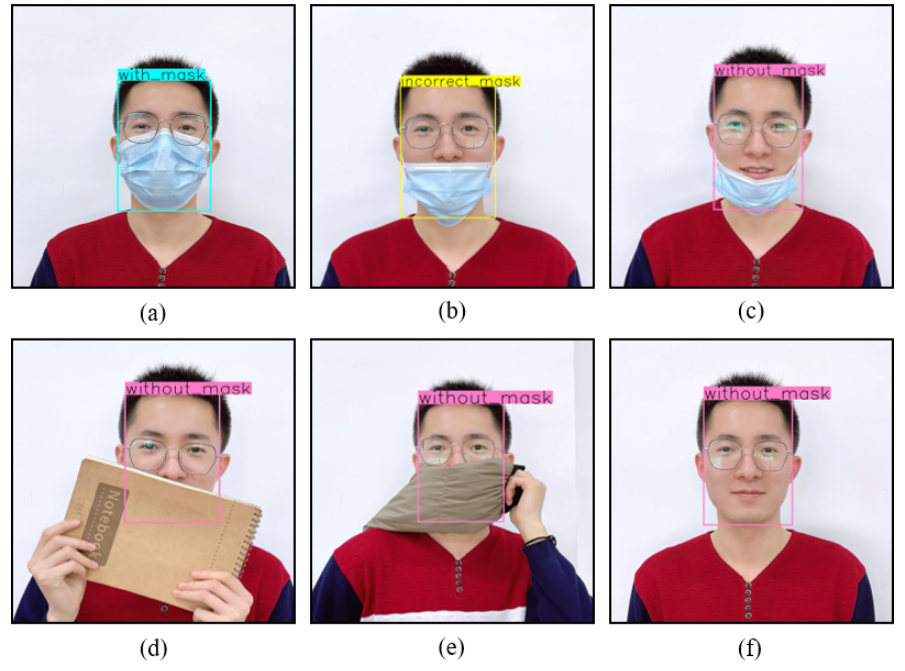
Figure 4. ( a ) Faces with both nose and mouth covered are labeled as “with_mask”. ( b ) Faces with nose uncovered are labeled as “incorrect_mask”. Face with mask below chin ( c ), with other objects covered ( d ), with clothes covered ( e ), and without mask ( f ) are labeled as